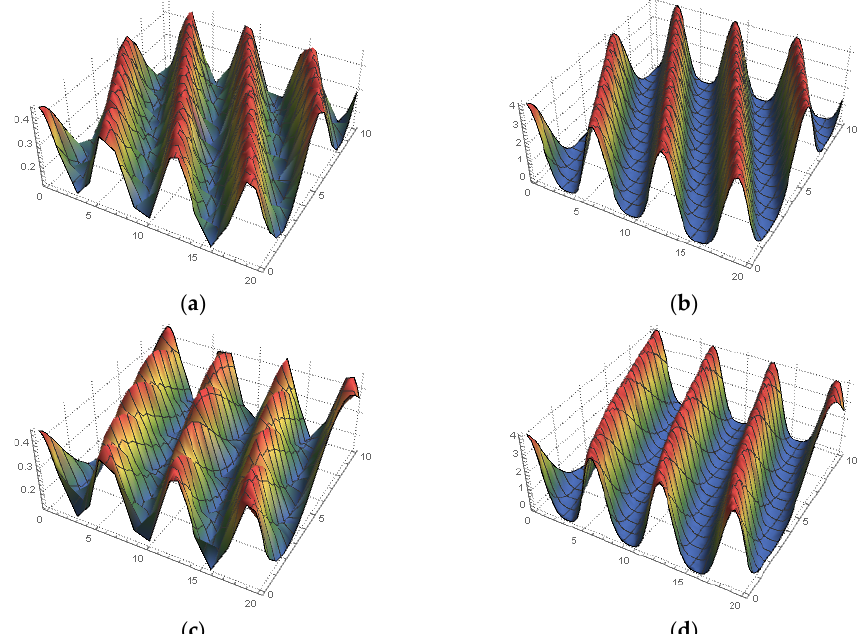
and with the parameters Figure 3. The 3D plots of Figure 3. The 3D plots of | F 5 ( x , t ) | 2 and | G 5 ( x , t ) | 2 with the parameters r 1 = r 2 = − 1, k 1 = k 2 = 1, and for various values: ( a ) , ( b ) 2 2 q 0 = 0.05, p 3 = − 0.3, q 1 = 2, ρ = 1 and τ = 0 for various α values: ( a ) | F 5 | 2 , α = 1, ( b ) | G 5 | 2 , α = 1, | 𝐹𝐹 5 ( 𝑥𝑥 , 𝑑𝑑 )| | 𝐺𝐺 5 ( 𝑥𝑥 , 𝑑𝑑 )| 𝑟𝑟 1 = 𝑟𝑟 2 = − 1, 𝑘𝑘 1 = 𝑘𝑘 2 = ( c ) and ( d ) 2 2 ( c ) | F 5 | 2 , α = 0.75 and ( d ) | G 5 | 2 , α = 0.75. | 𝐹𝐹 5 | | 𝐺𝐺 5 | 1, 𝑞𝑞 0 = 0.05, 𝑝𝑝 3 = − 0.3, 𝑞𝑞 1 = 2, 𝜌𝜌 = 1 𝜏𝜏 = 0 𝛼𝛼 , 𝛼𝛼 = 1 , 𝛼𝛼 = 2 2 | 𝐹𝐹 5 | | 𝐺𝐺 5 | 1, , 𝛼𝛼 = 0.75 , 𝛼𝛼 = 0.75. Figures 4 and 5 show 3D plots of the real and imaginary parts of the periodic wave solutions and in with some se- lected physical free parameters and different fractional orders. The regularity, harmony ( 𝑥𝑥 , 𝑑𝑑 ) ∈ [0,20] × [0,10] 𝐹𝐹 6 ( 𝑥𝑥 , 𝑑𝑑 ), 𝐹𝐹 7 ( 𝑥𝑥 , 𝑑𝑑 ), 𝐺𝐺 6 ( 𝑥𝑥 , 𝑑𝑑 ), 𝐺𝐺 7 ( 𝑥𝑥 , 𝑑𝑑 ) and compatibility of the periodic wave solutions can be observed for different values in all cases. 𝛼𝛼